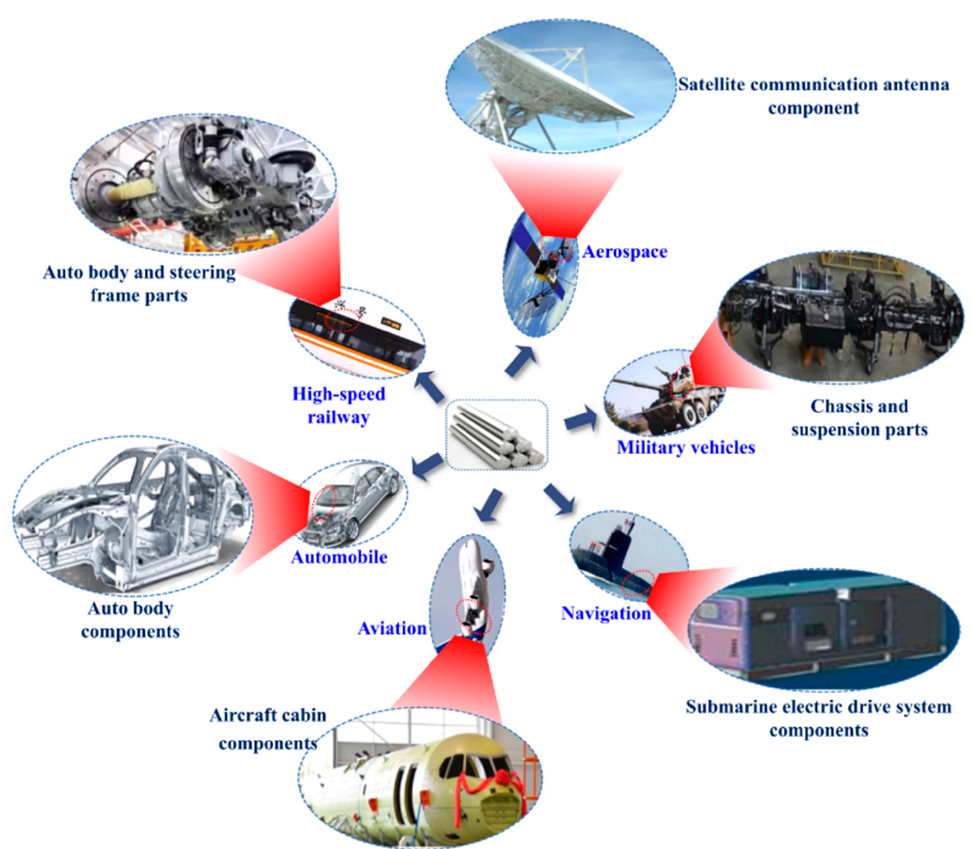
Figure 1. Typical uses of aluminum alloys in industrial manufacturing.